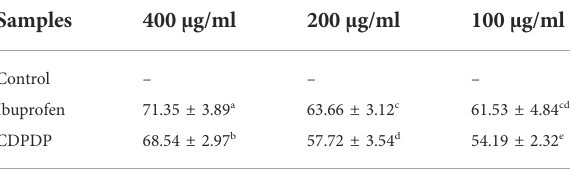
TABLE 1 In vitro anti-in fl ammatory assessment of